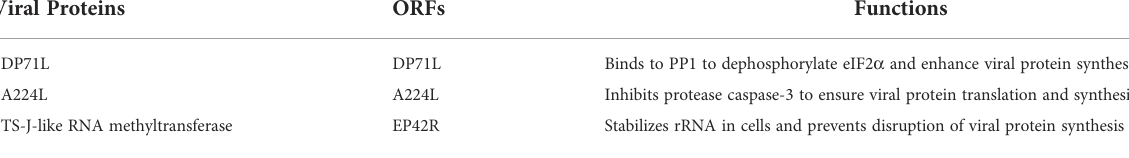
TABLE 4 ASFV encodes related proteins involved in genome